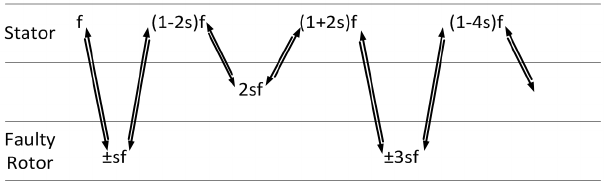
Figure 2. Effect of speed ripple on stator and rotor current of SAASMs due to rotor asymmetry